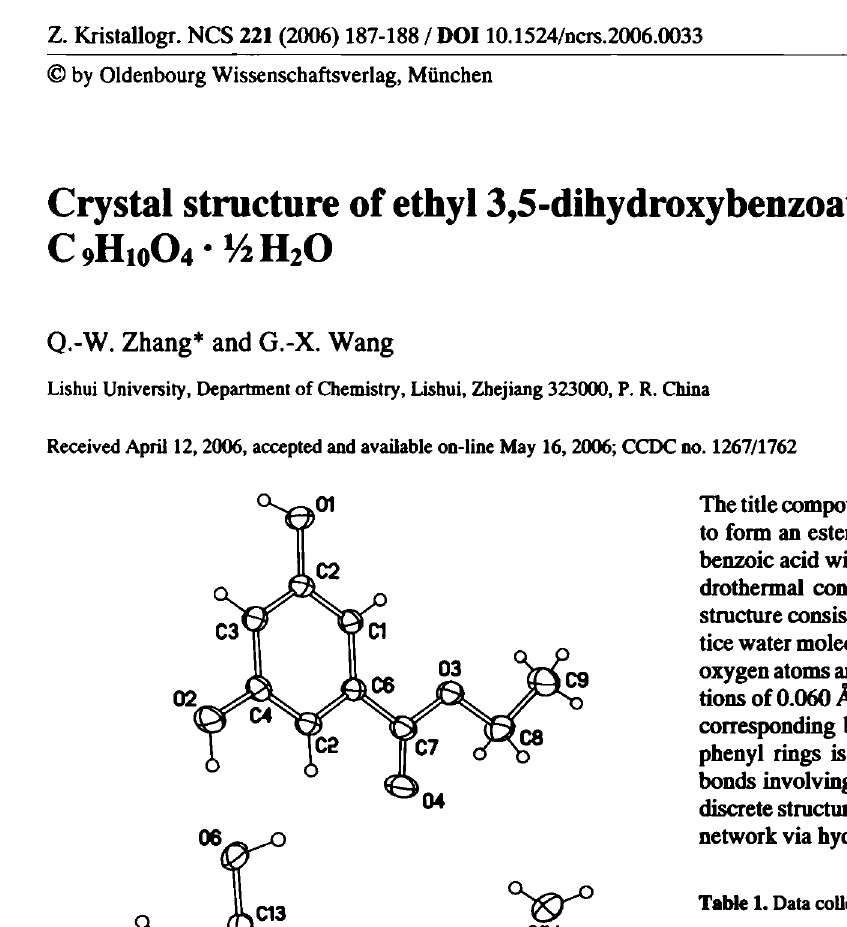
Table 2. Atomic coordinates and displacement parameters (in Ä 2